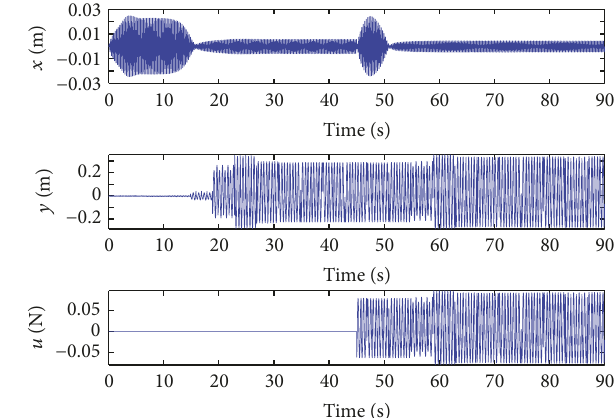
Figure 13: Dynamic response of the primary system, with autopara- metric interaction, using the passive/active beam absorber and PZT actuator switching the stiffness feedback exactly at the frequency change ( 𝜀𝜌 1 = +0.15 rad/s).